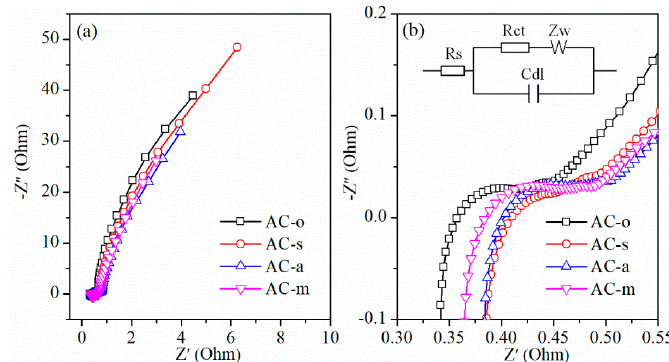
Figure 8. Nyquist plots ( a ) and Nyquist plots at relatively high frequency regions ( b ) of the samples. The inset showed the equivalent electrical circuit.